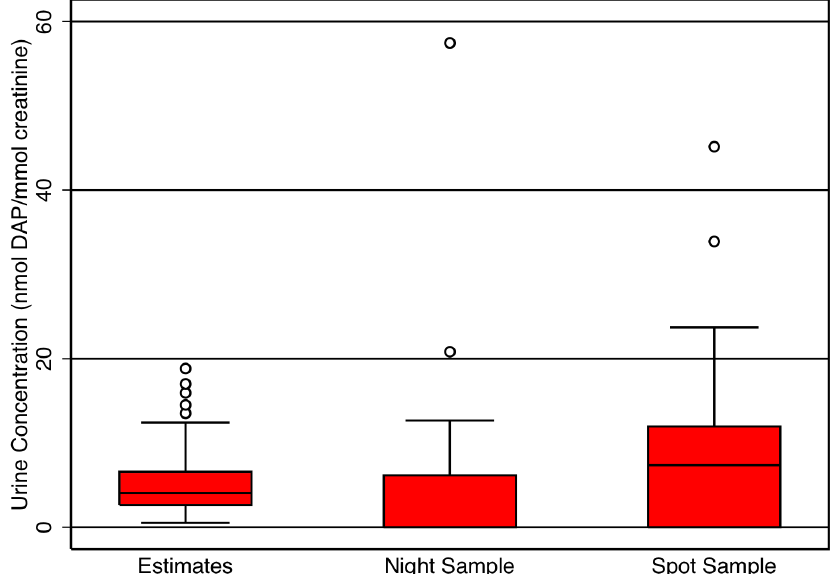
Figure 3. Comparison of DAP urine concentration estimated by CACHED for the children that had their activities videotaped [22] with the DAP concentration measured in the overnight and spot urine samples of farmworker children